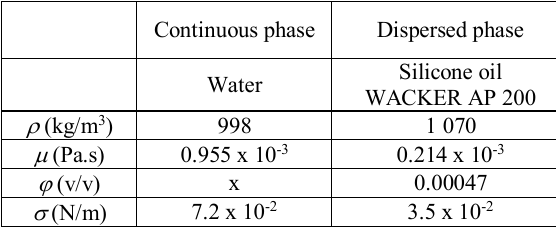
Table 2. Physical properties of immiscible liquid-liquid system